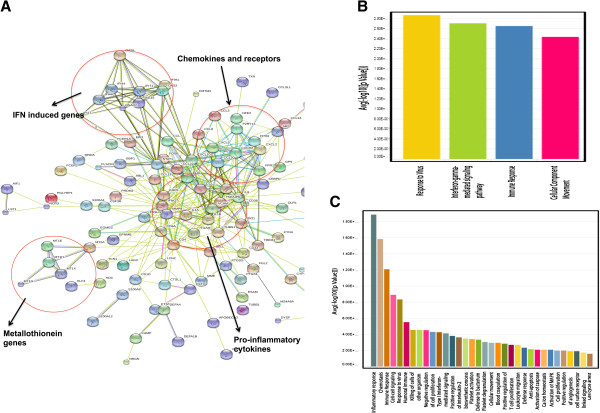
Predicted interaction networks of genes significantly dysregulated in HVL compared to Control. (A) The interactions between genes were identified using STRING software. Colored lines indicate different sources of evidence for each interaction. Circles highlight the predominant clusters within the network. (B & C) Gene Ontology Enrichment analysis for biological processes using significantly differentially regulated genes in LVL and HVL groups in comparison with CT group. Genes that are differentially regulated in LVL group relative to the CT yielded 4 significant terms for biological processes (B), while those that are differentially regulated in HVL with respect to CT yielded 34 (C). Bar graphs are generated using average –lop of p value for each term on y-axis and term name on x-axis. CT, uninfected control; LVL, low viral load group; HVL, high viral load group.